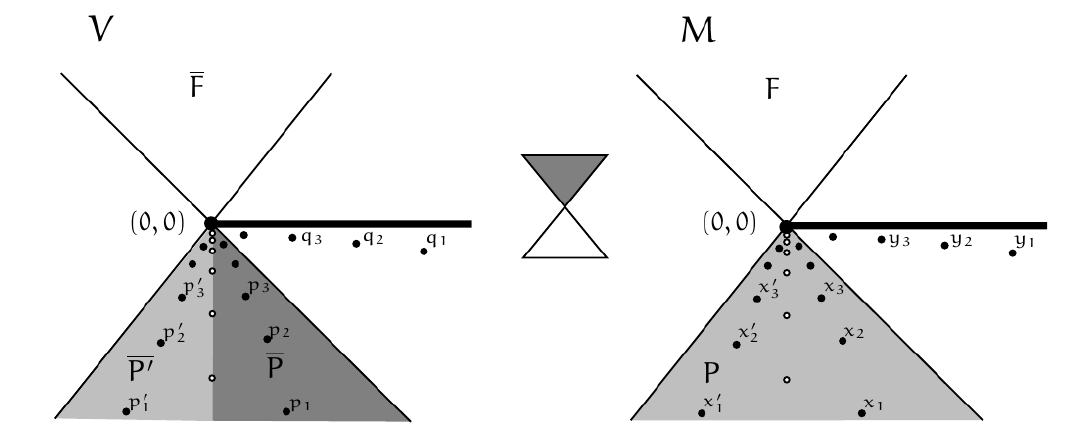
Figure 5 . The space M (on the right) is L 2 with the line r = f ( x; 0 ) : x > 0 g and the sequence of ) g n removed, while V is the universal cover of M . On the (cid:12)rst one, associated to the points f ( 0; - 1 n point ( 0; 0 ) we have the point ( P; F ) 2 @M . However, the set P lifts to a (cid:12)xed (cid:12)bre f 0 g (cid:2) M (cid:26) V as two di(cid:11)erent terminal past sets P and P 0 , creating two di(cid:11)erent points ( P 0 ; F ) ; ( P; ; ) 2 @V . In particular, it follows that the sequence f y n g n depicted on the right is not convergent, while its lifts f q g n n converges to ( P; ; )